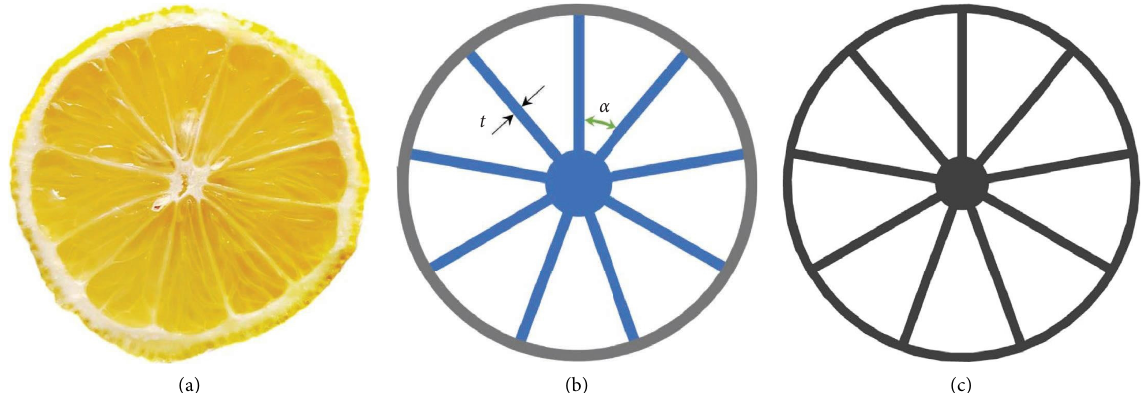
Figure 2: Te development of NLII structure: (a) lemon (citrus) fruit structure, (b) sublayers of NLII structure and (c) CAD geometry of NLII structure.